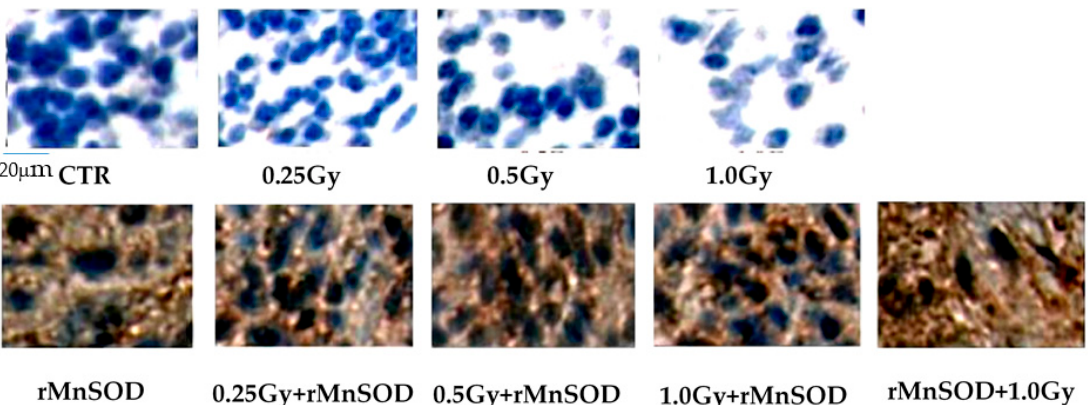
Figure 1. Localization of rMnSOD in brain tissue. Immunohistochemical analysis was performed by using specific antibody. The immunostaining was evident only in brain samples from rMnSOD-treated mice.